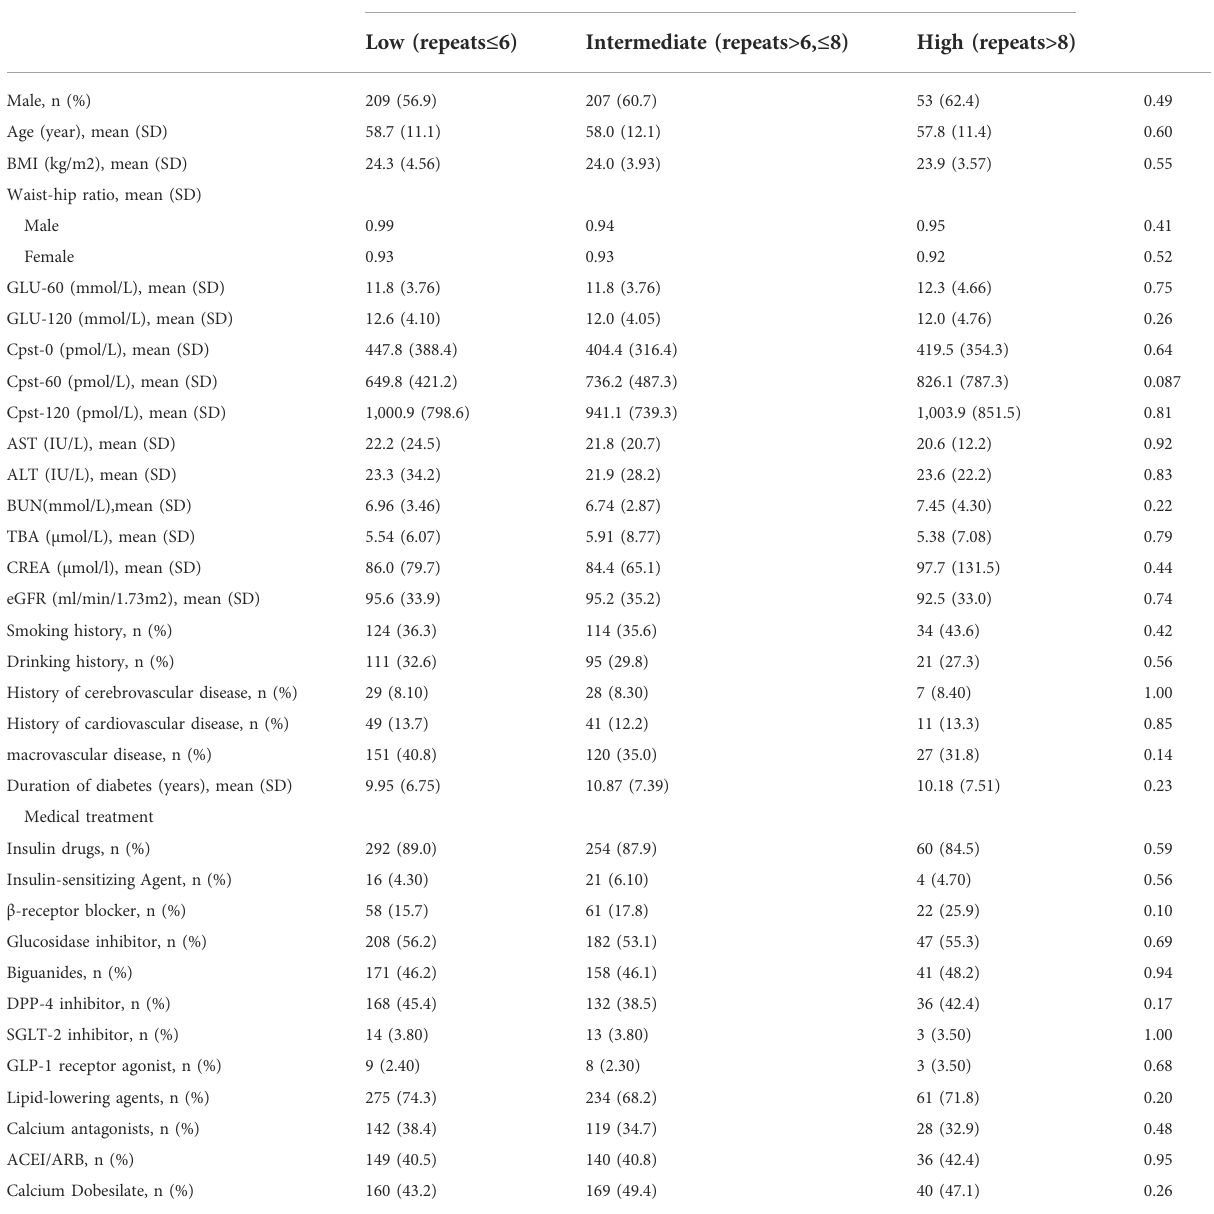
TABLE 1 The characteristics of T2DM patients.